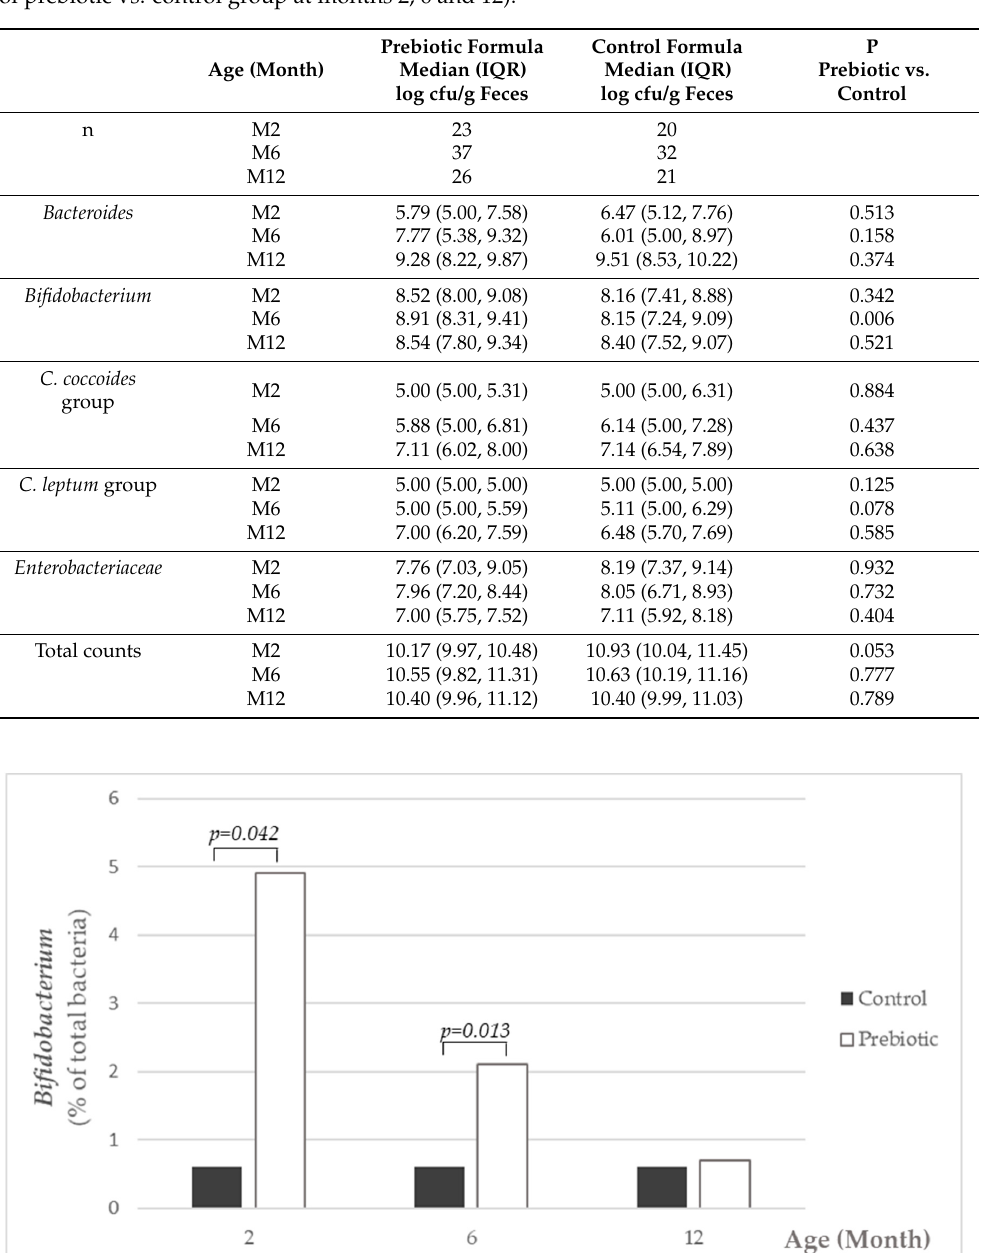
Table 2. Fecal microbiota counts by group (median (IQR) of log cfu/g feces and statistical comparison of prebiotic vs. control group at months 2, 6 and 12).